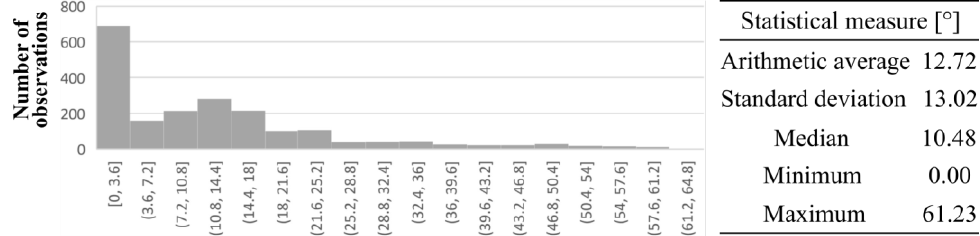
Figure 11. A histogram of error distribution course determination by the satellite compass with the sample statistical parameters.